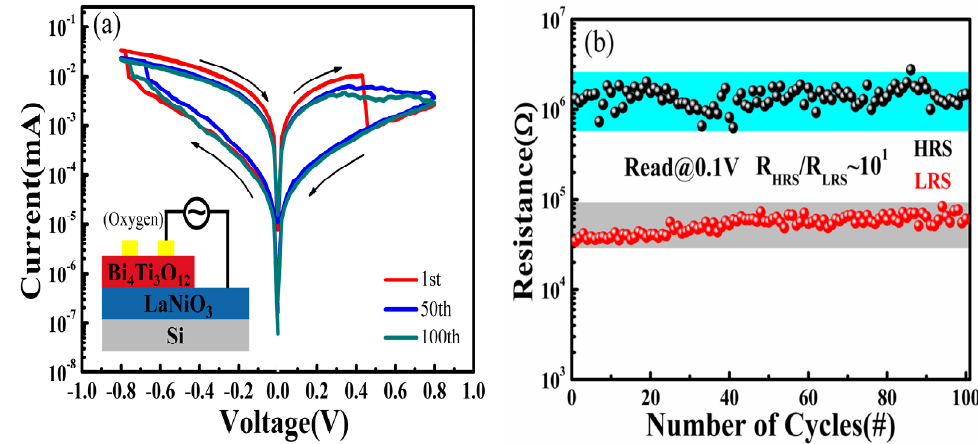
Figure 6. ( a ) Semilogarithmic I − V curve of the device under 100 voltage sweep cycles. ( b ) Resistance of HRS and LRS read at a bias of +0.1 V.